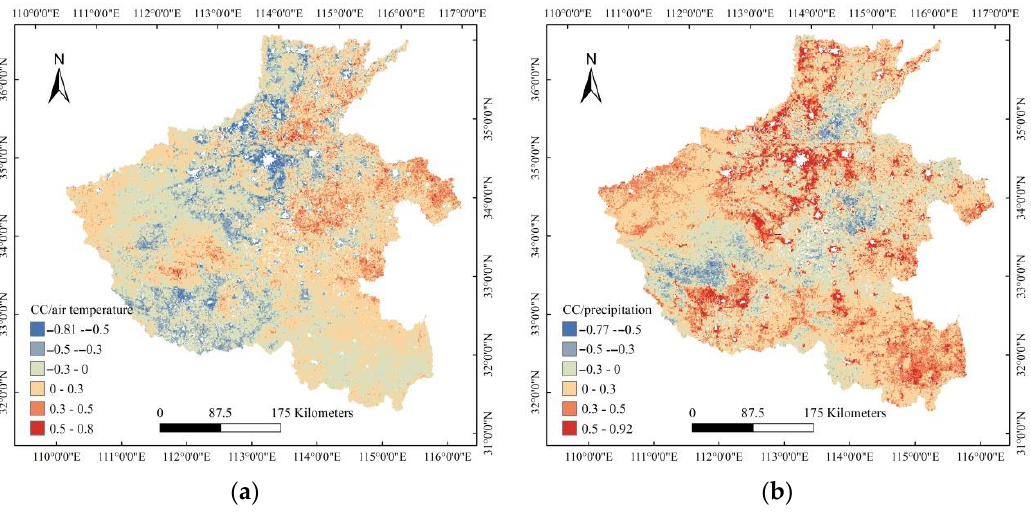
Figure 10. Spatial distributions of correlation coefficient between ET and air temperature ( a ), and between ET and precipitation ( b ) in Henan province 2000 – 2020. Table 3. Regional statistics of correlation coefficients between ET and air temperature and precip- itation, respectively.